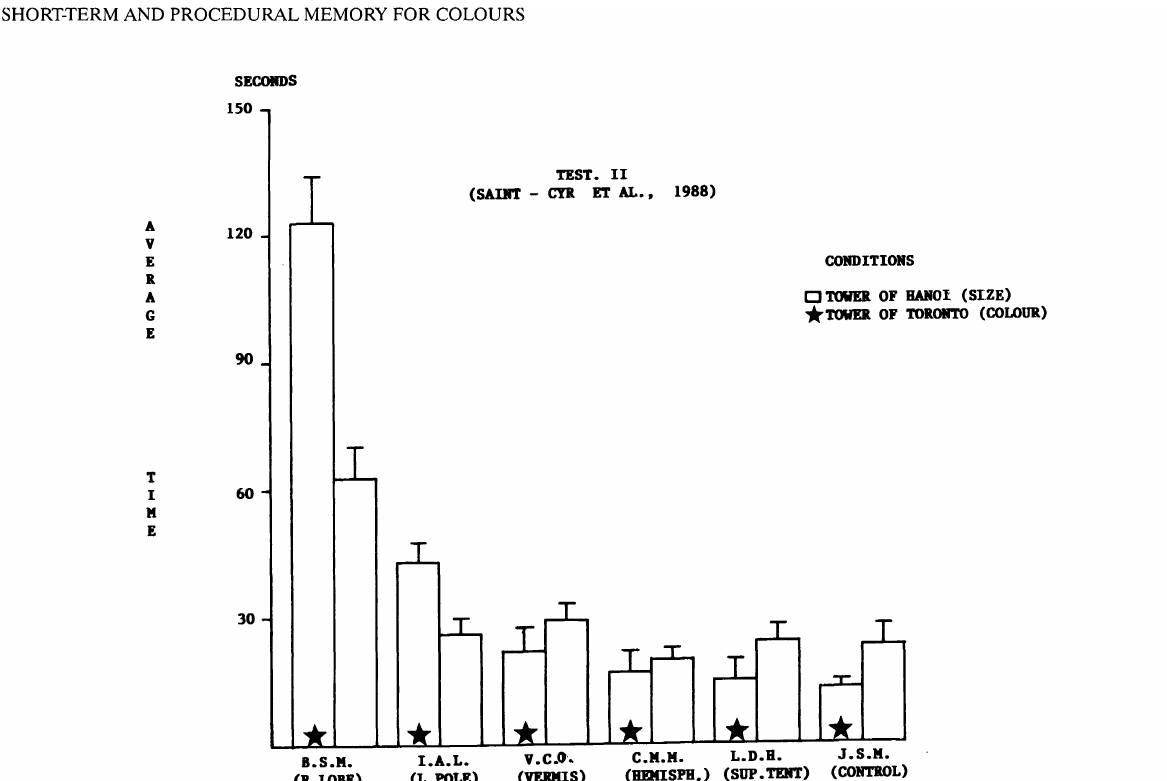
FIG. 4. Histogram showing results of I.A.L. (tumour of left temporal pole), B.S.M (tumour of right temporal lobe) and each of the subjects selected from the VER, HEM, ST and CON groups in either colour (Tower of Toronto) or size (Tower of Hanoi) pro cedural learning tasks (modified from Saint-Cyr et a/., 1988). Each column refers to average time spent by each subject in three trials of each task.